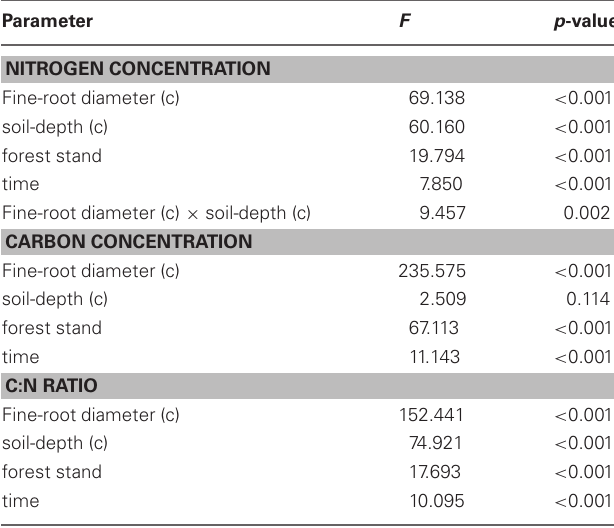
Table 1 | General linear model analysis (two-way ANCOVA) for the effects of forest stand and time on fine-root N and C concentrations and C:N ratio.